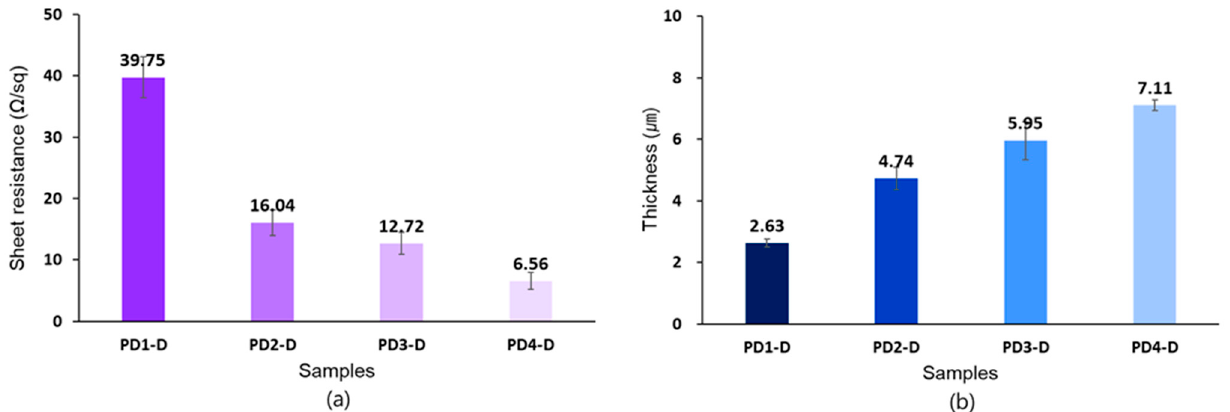
Figure 3. Changes in ( a ) electrical sheet resistance and ( b ) thickness as the coating cycle increased once (PD1-D), two (PD2-D), three (PD3-D) and four times (PD4-D).